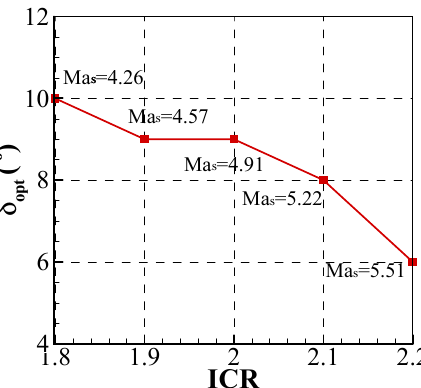
Figure 14. Effects of the cowl lip angle on starting performance of inlets with various ICRs.